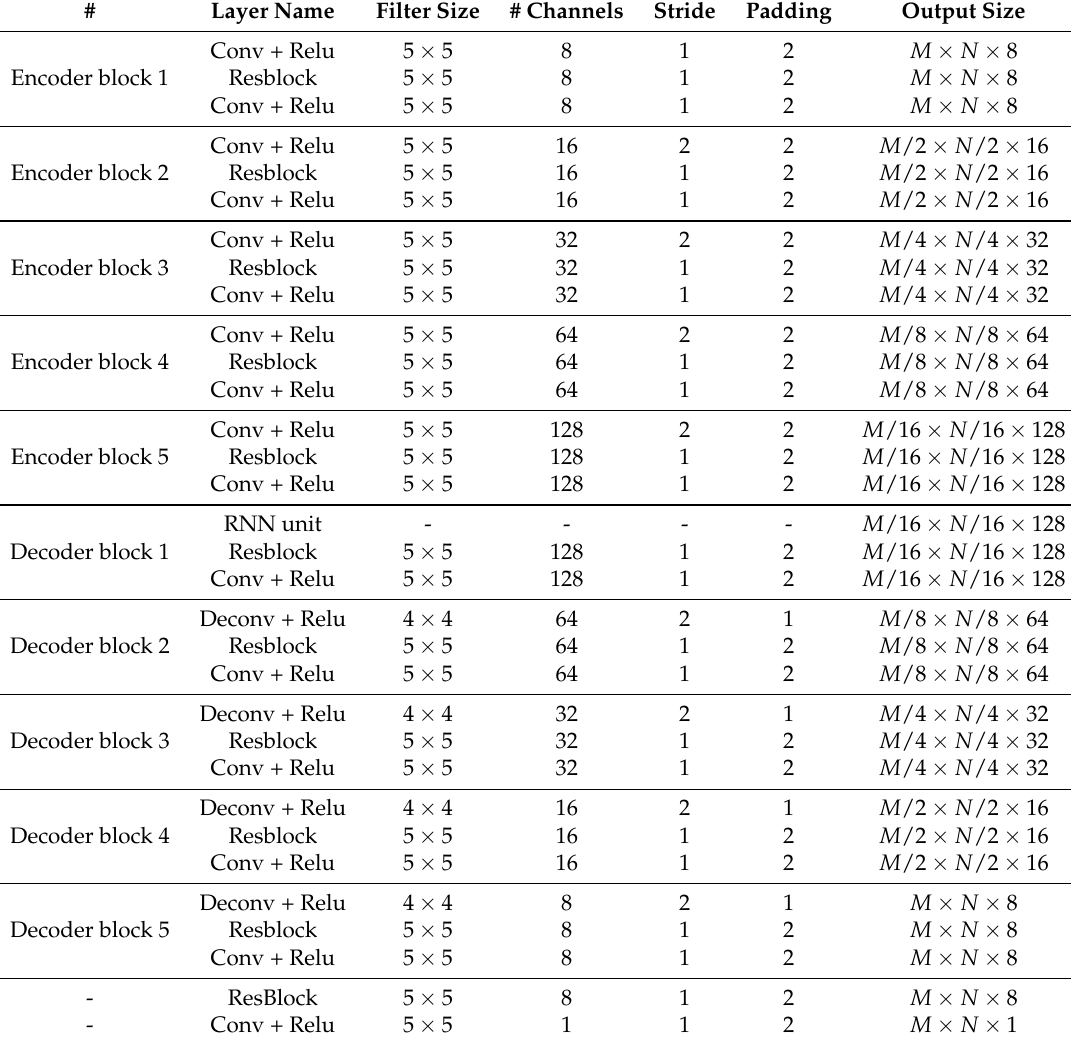
Table 1. Detailed parameter configuration of each